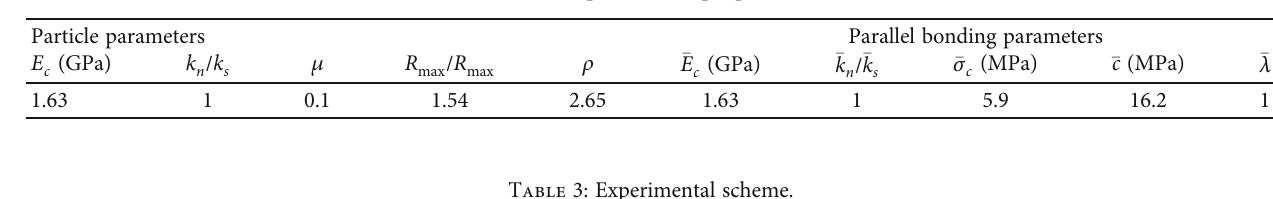
Table 2: Sample microscopic parameters.